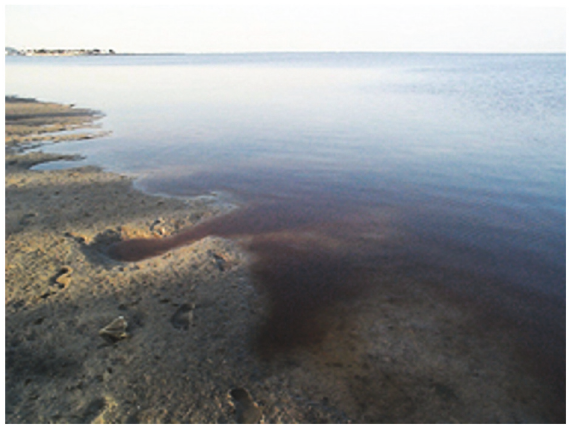
Figure 2: Karenia brevis proliferation. Source: Florida Fish and Wildlife